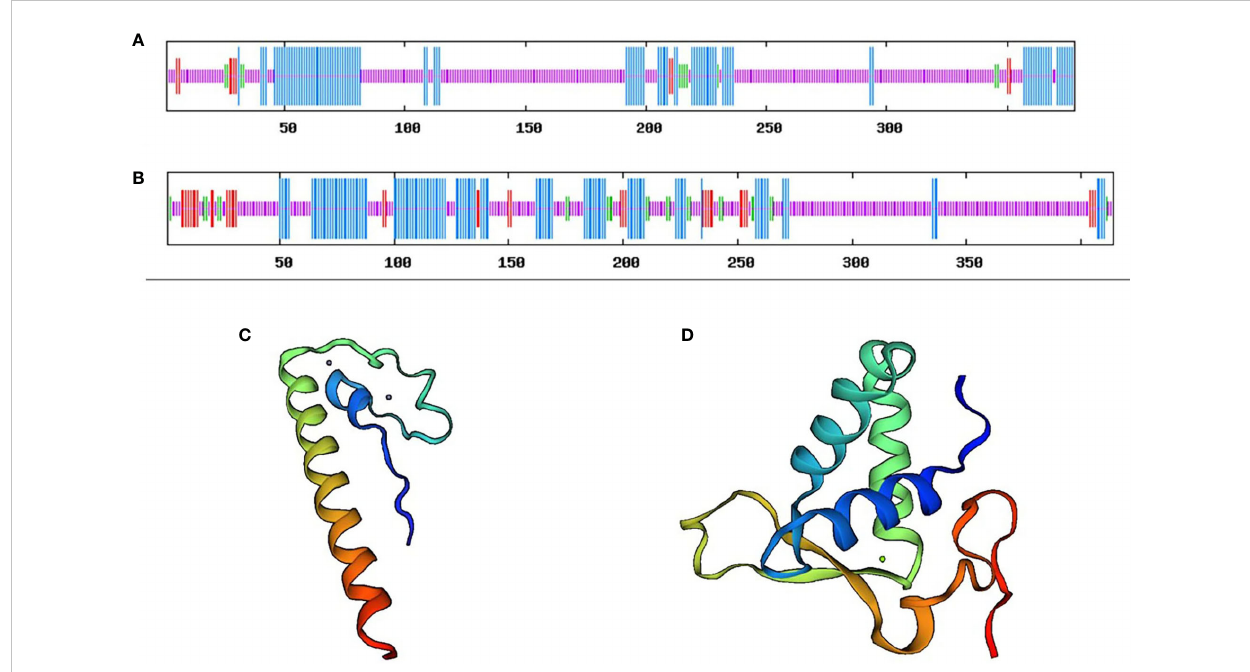
FIGURE 2 The secondary structure and tertiary structure prediction of DMRT3 (A) and FOXL2 (B) in C. sinensis . Blue represents the alpha helix, red represents the extended strand, green represents the beta-turn, and orange represents the random